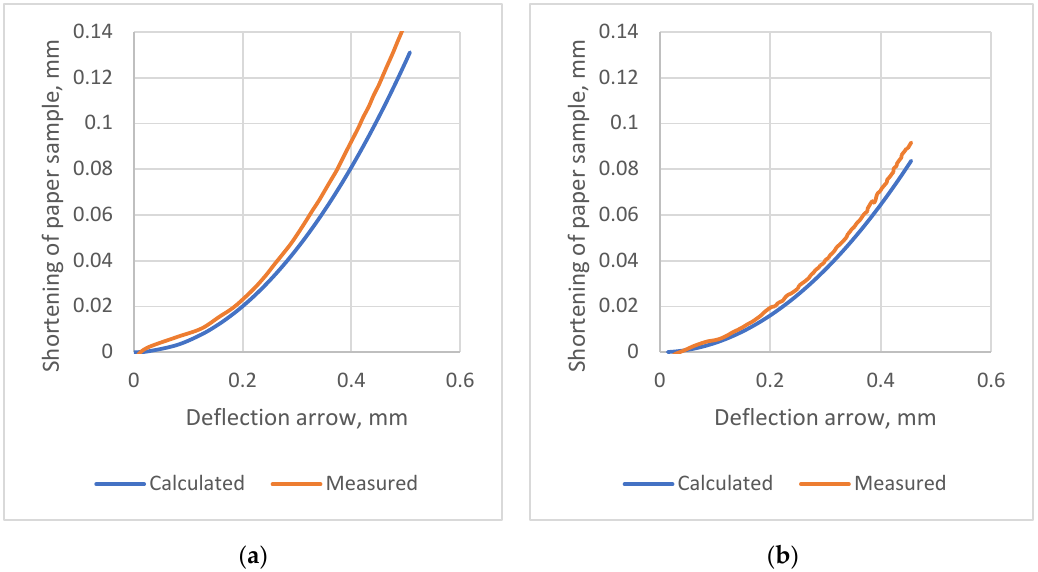
Figure 16. Comparison of the measured and theoretically calculated sample shortening during the test for clamping length of ( a ) 4 mm and ( b ) 5 mm.